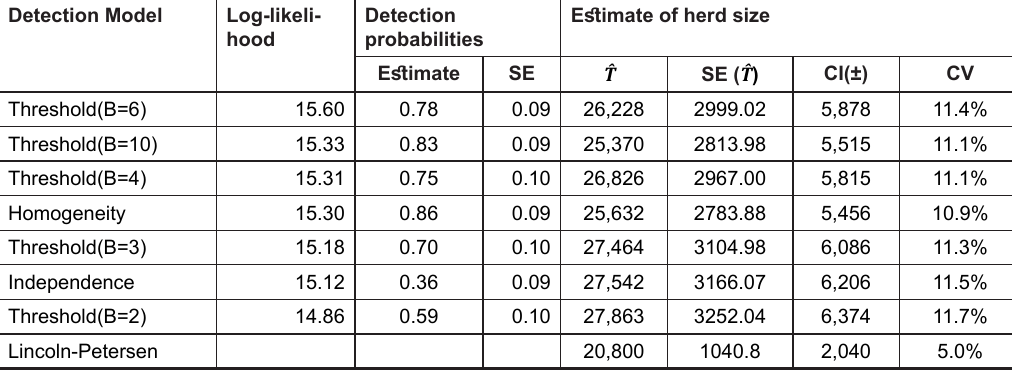
Table 8. Rivest estimator results and LP estimate for the Bluenose-West 2005 survey.